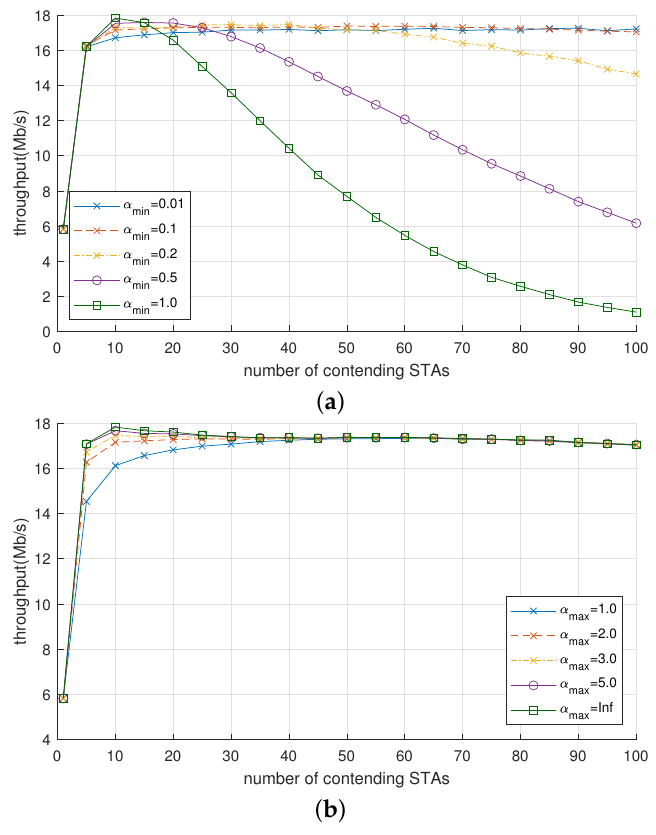
Figure 8. Effect of ( a ) α min and ( b ) α min on the throughput of OBO_CTRL .